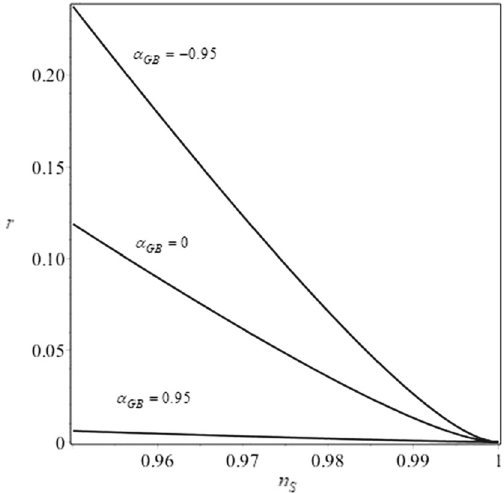
Fig. 2 The r = r ( n S ) diagram for μ 2 = 12 and different values of the coupling constant α